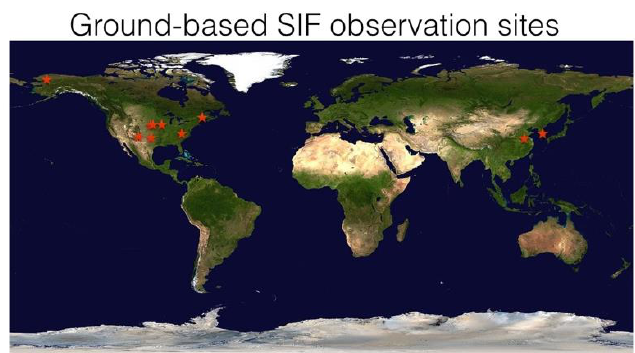
Figure 6. An example of data collected by FluoSpec 2 at noon. ( A ) Irradiance collected by the upward- looking cosine corrector and radiance collected by fiber optics pointing to the tree canopy. ( B ) Five consecutive reflectance spectra collected in ten minutes, calculated as radiance/irradiance.